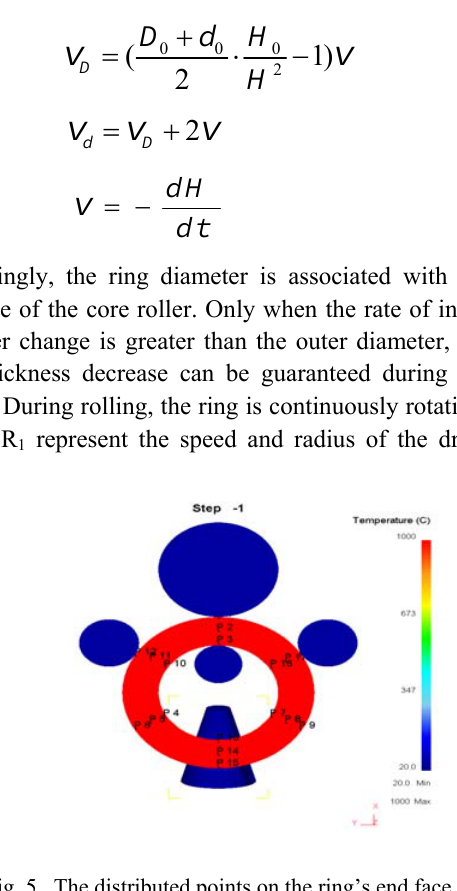
Fig. 6. The distributed points on the ring’s